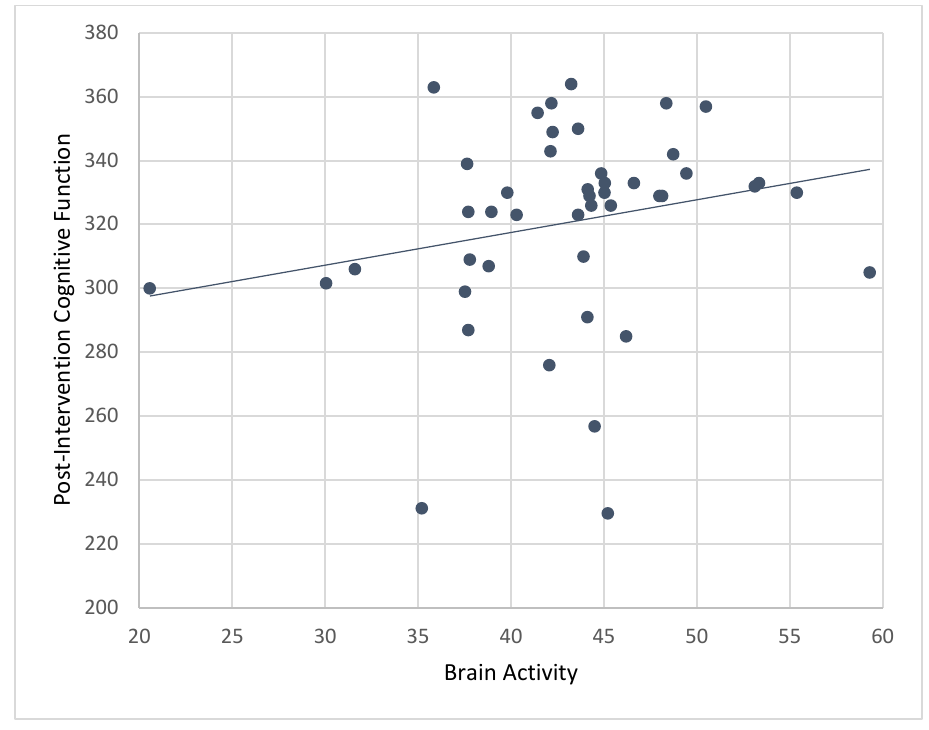
Figure 7. Correlation between post-intervention composite cognitive function and brain activity for the treatment (ABC) group. Mean levels of brain activity during ABC training were significantly associated with post-treatment composite cognitive function (r = 0.45, p < 0.001).